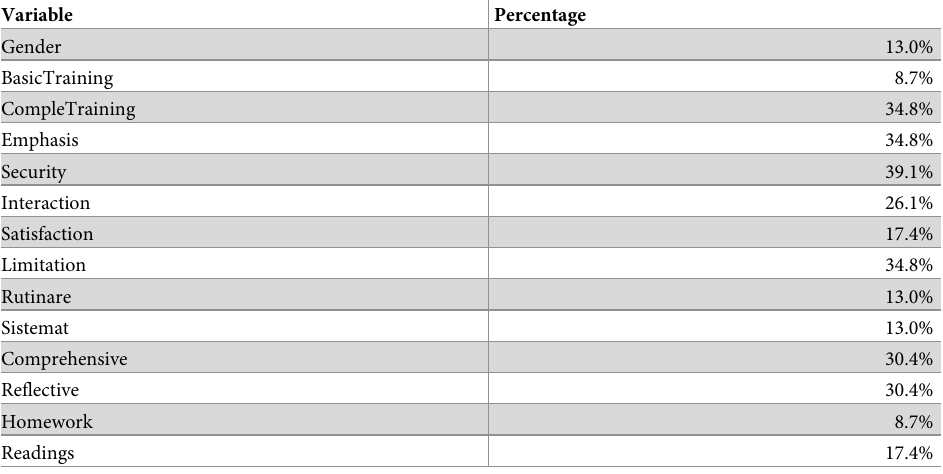
Table 8. Percentage of countries where the coefficient was significant for variables related to